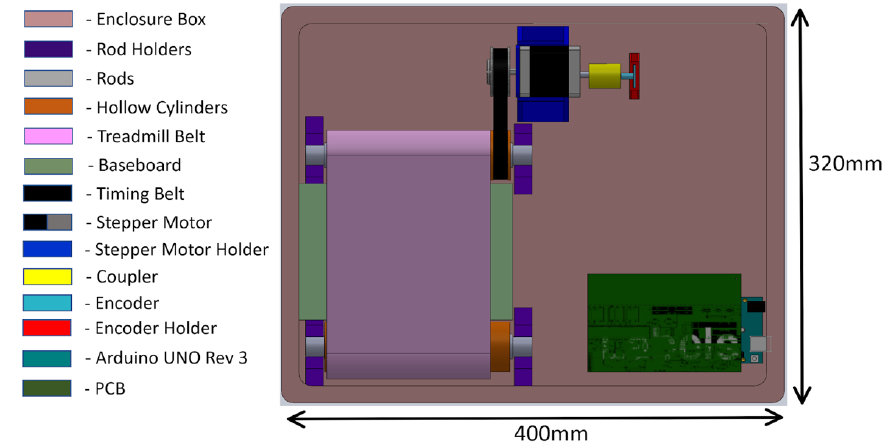
Figure 4. Mechanical design of the treadmill with enclosure.